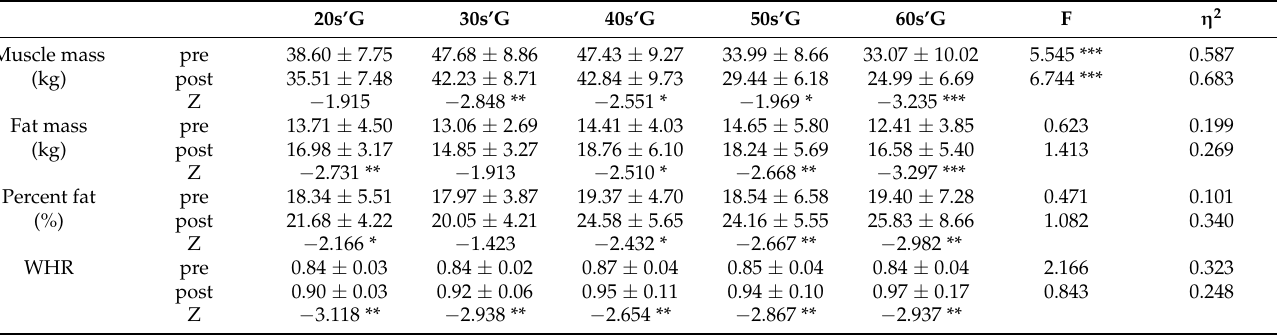
Table 2. Differences and changes in body composition among 5